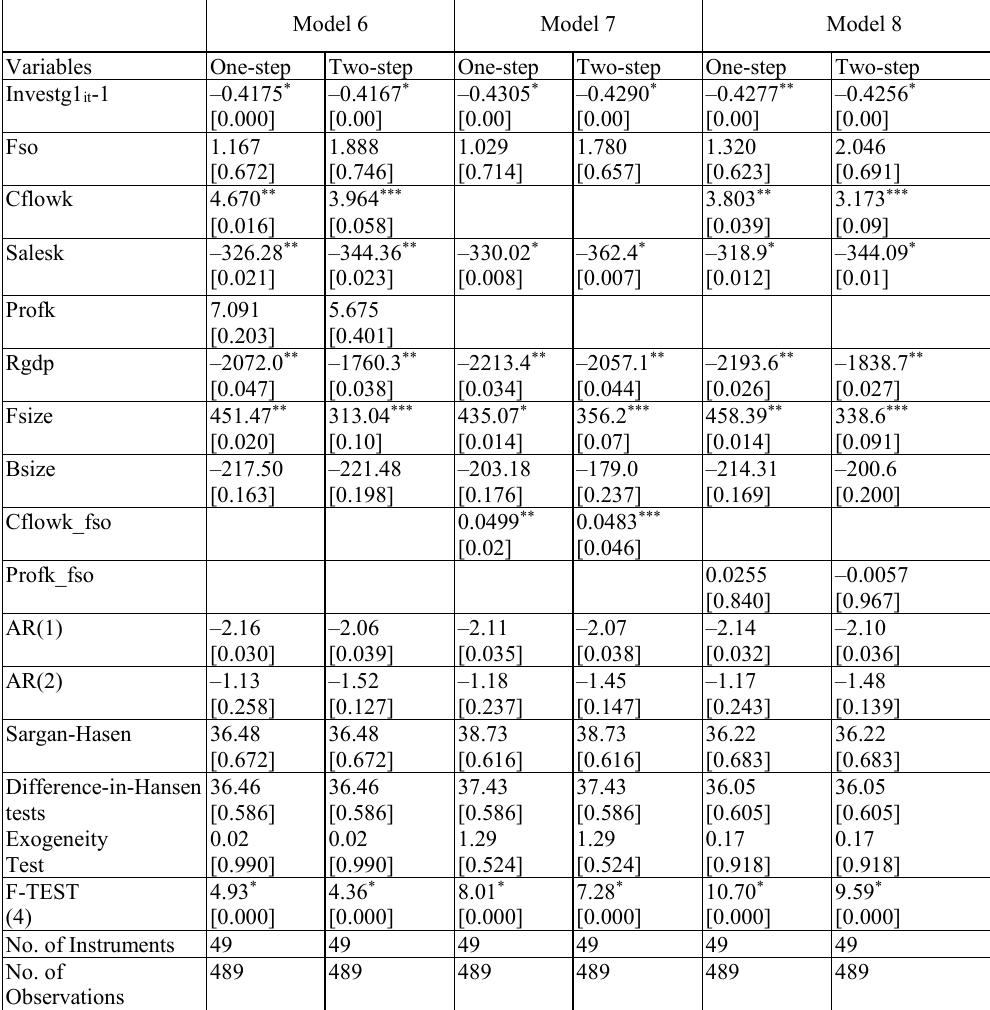
Table 1. Dynamic Panel Regression Result for the Sampled (Aggregated) Firms with DEPENDENT VARIABLE as Investment Growth (INVESTG 1 ) Model 6 Model 7 Model